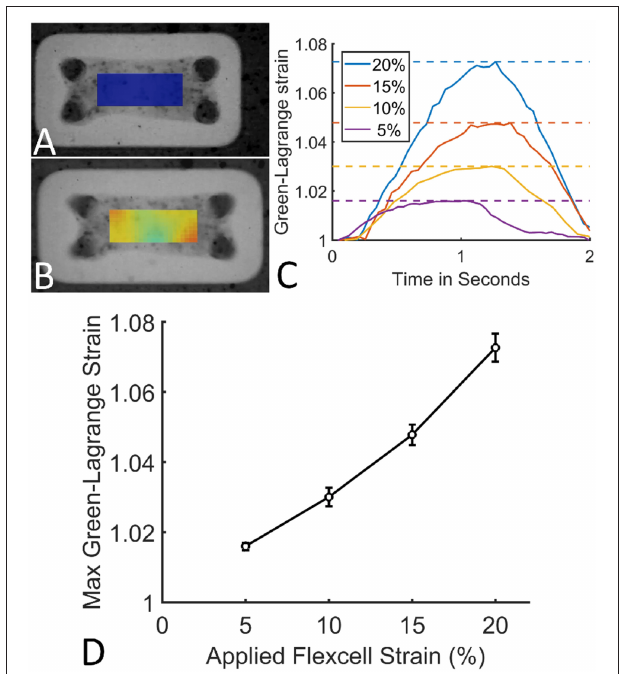
FIGURE 6 | (A) A microtissue without externally applied mechanical cues. (B) A dynamically cultured microtissue at 10% Flexcell strain. (C) Average actual microtissue Green-Lagrange strains during one cycle (2 s) for different applied Flexcell strains (legend). The dotted lines indicate the maximal strains during the cycles. (D) Maximum Green-Lagrange strains (averaged over the mid-section of the microtissues in B ) for increasing applied Flexcell